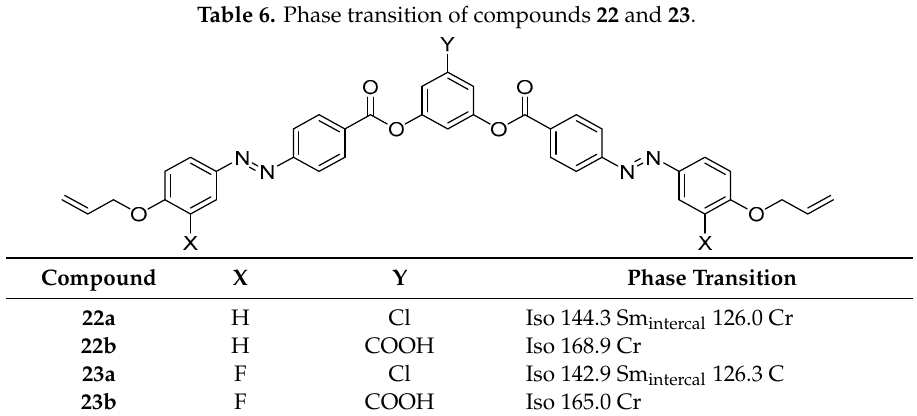
Table 6. Phase transition of compounds 22 and 23 .